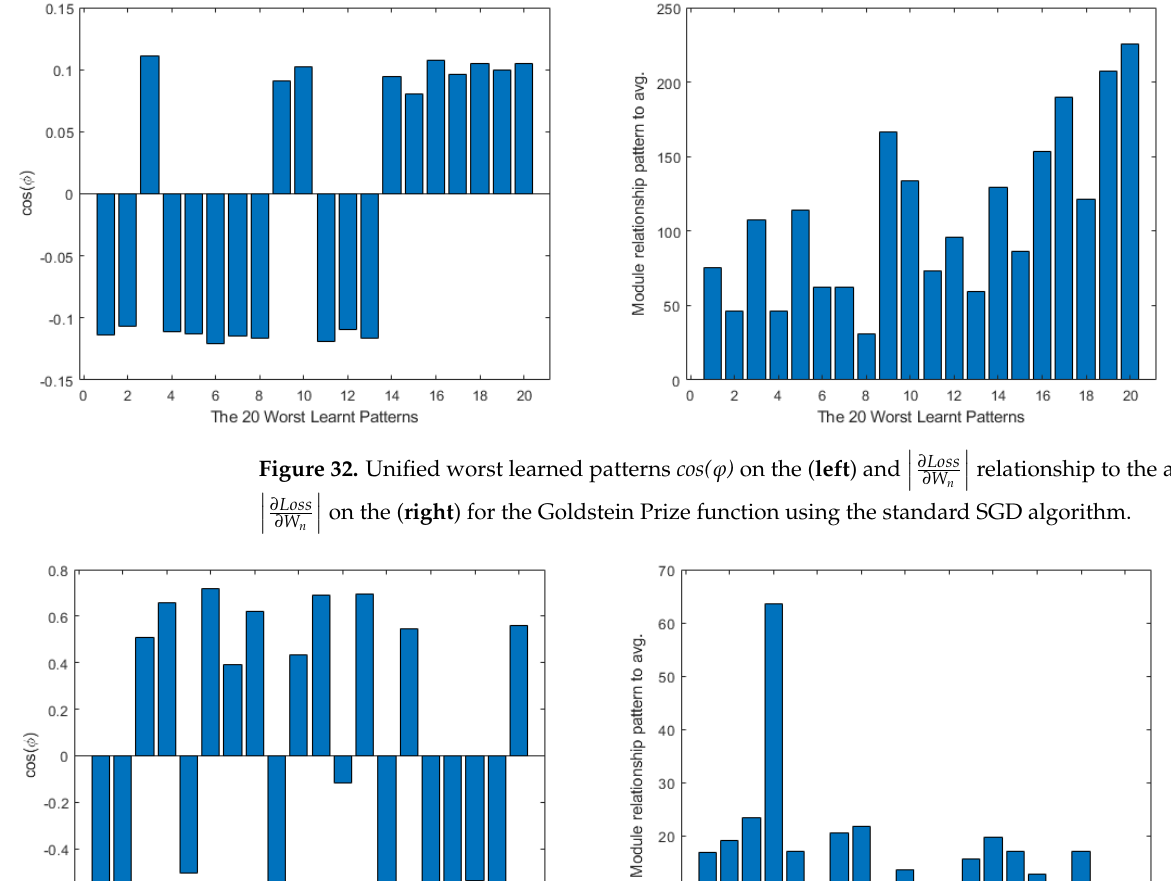
Figure 33. Unified best learned patterns cos(φ) on the ( left ) and | | 𝜕𝐿𝑜𝑠𝑠 | on the ( right ) for the Goldstein Prize function using the standard SGD algorithm. 𝜕𝑊 𝑛